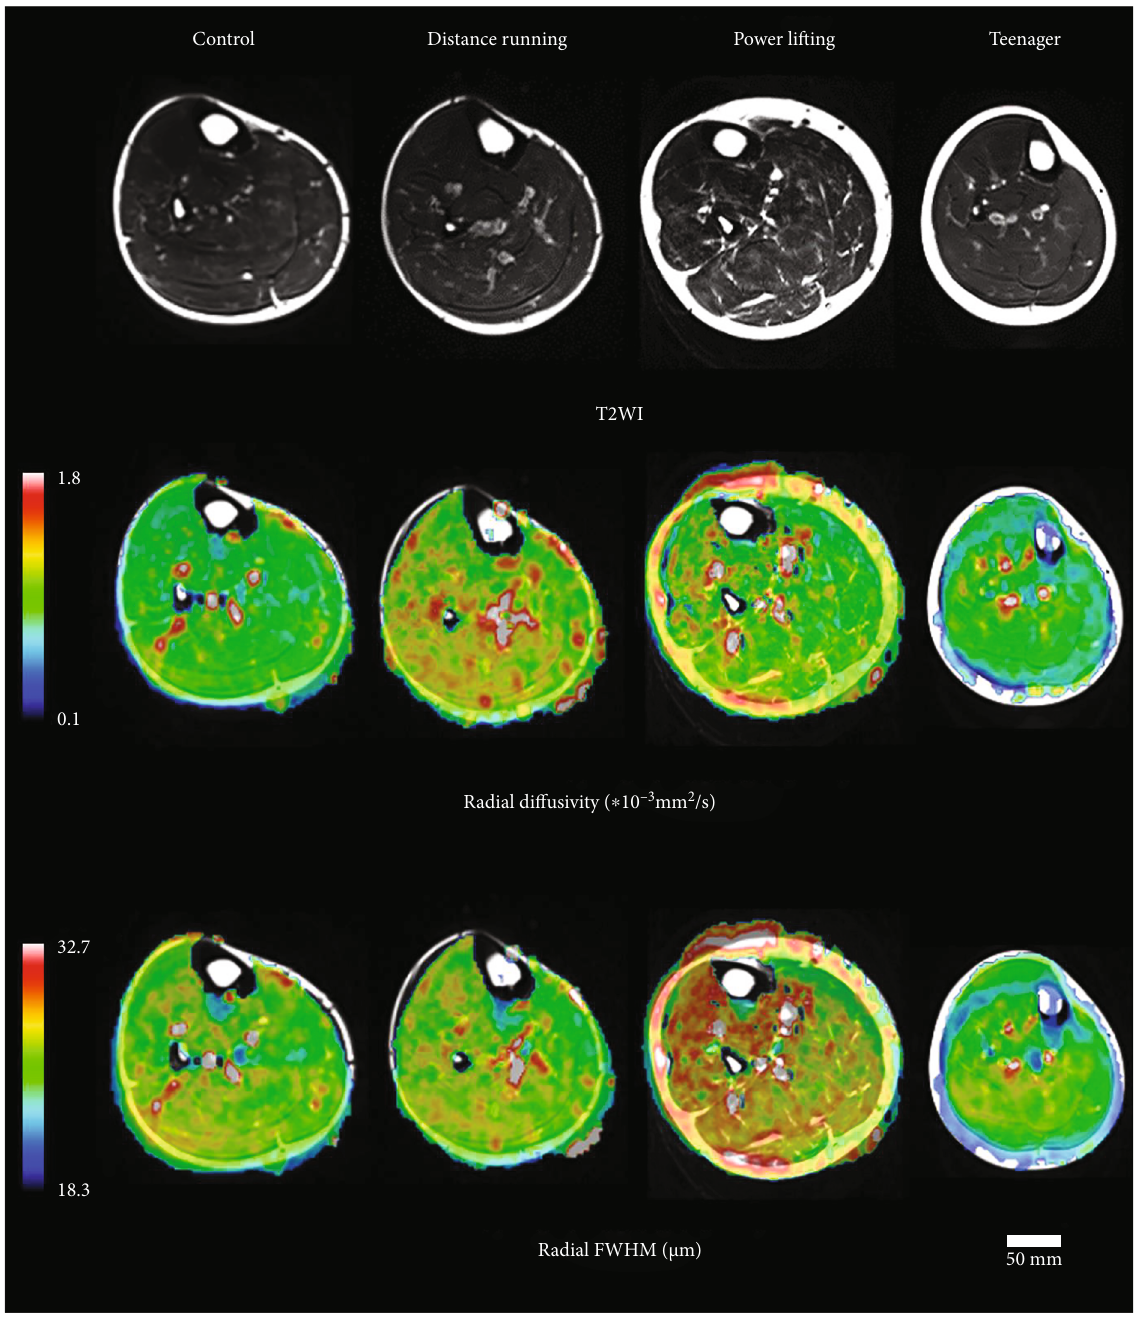
Figure 5: Color mapping axial sections of magnetic resonance imaging for the four groups. T2WI: T2-weighted imaging; FWHM: full width at half